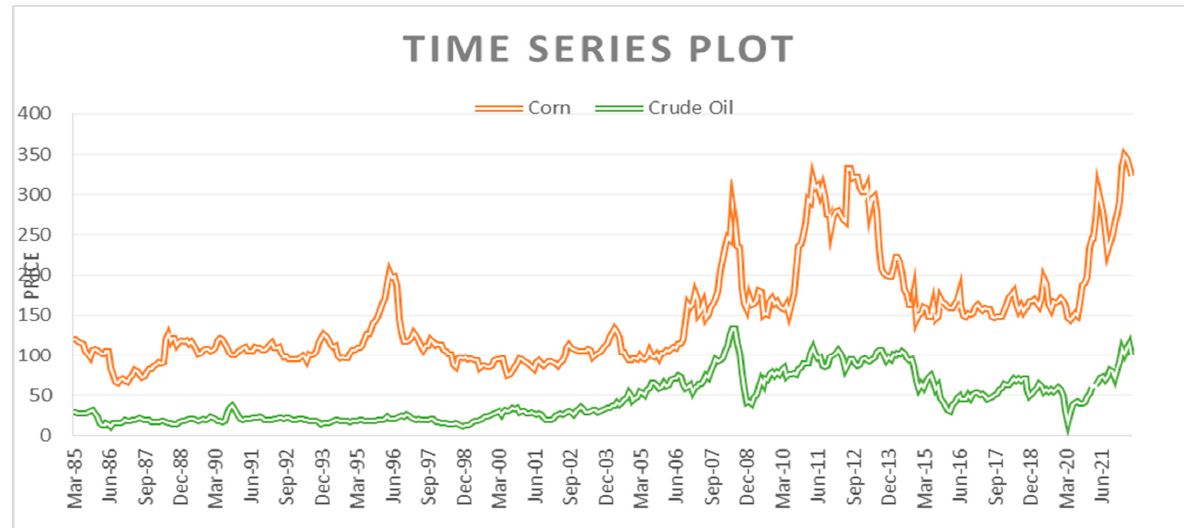
Figure 1. Time-Series Plot of Crude Oil and Corn Price Patterns.